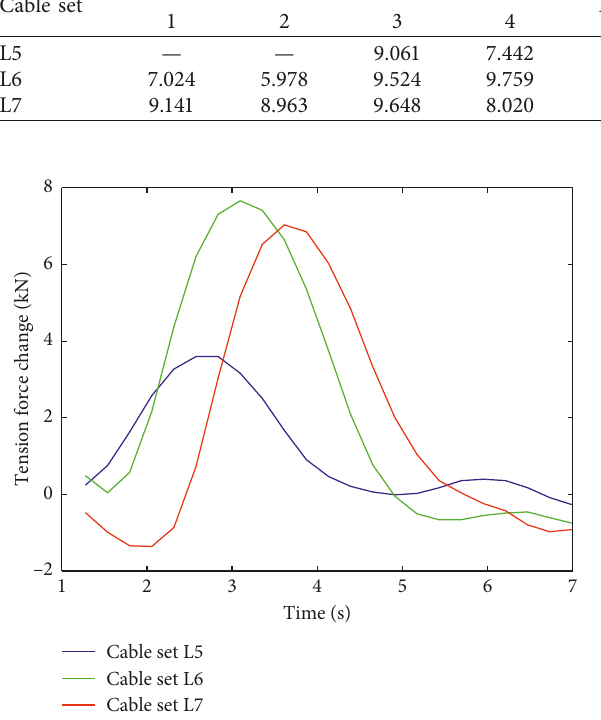
Figure 16: Time history of variation of the total forces in each cable